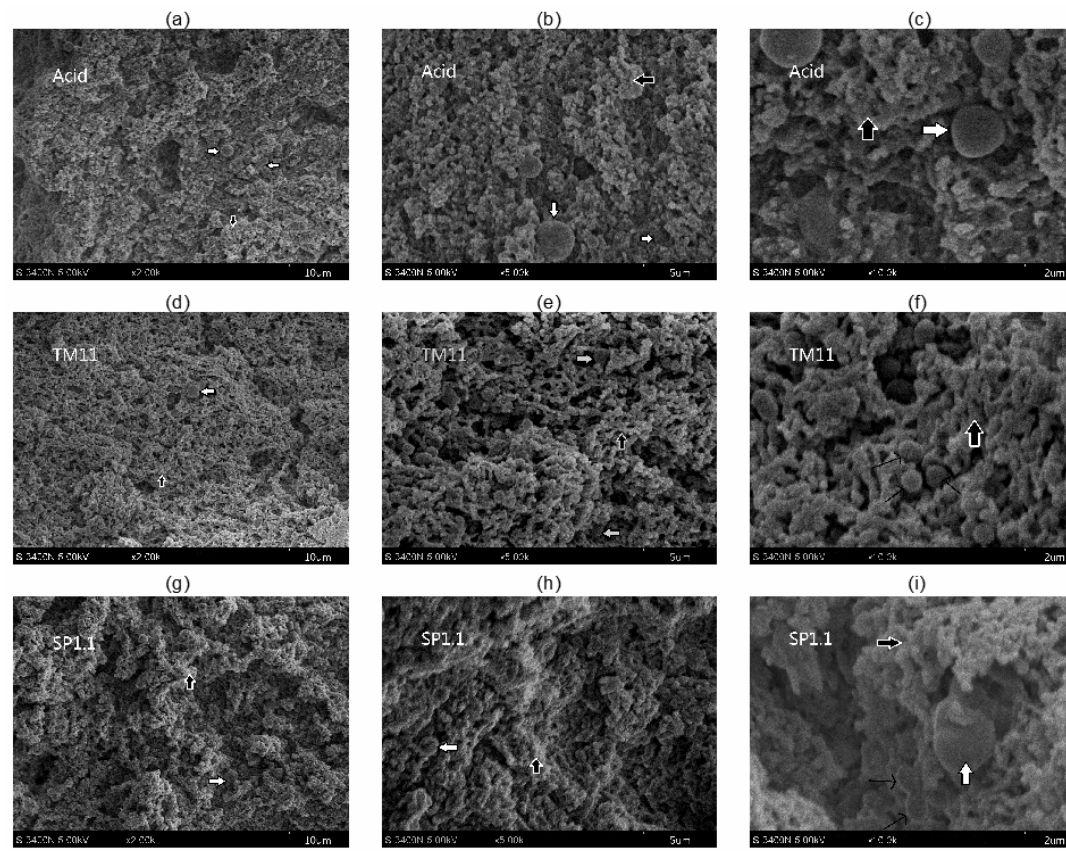
Figure 3. Microstructures of the direct-acidified cheese (DAC) and the cultured cheeses with S. thermophilus (TM11 and SP1.1). The white thick arrow points to fat globules. The black thick arrow points to the protein matrix. The thin arrow points to the